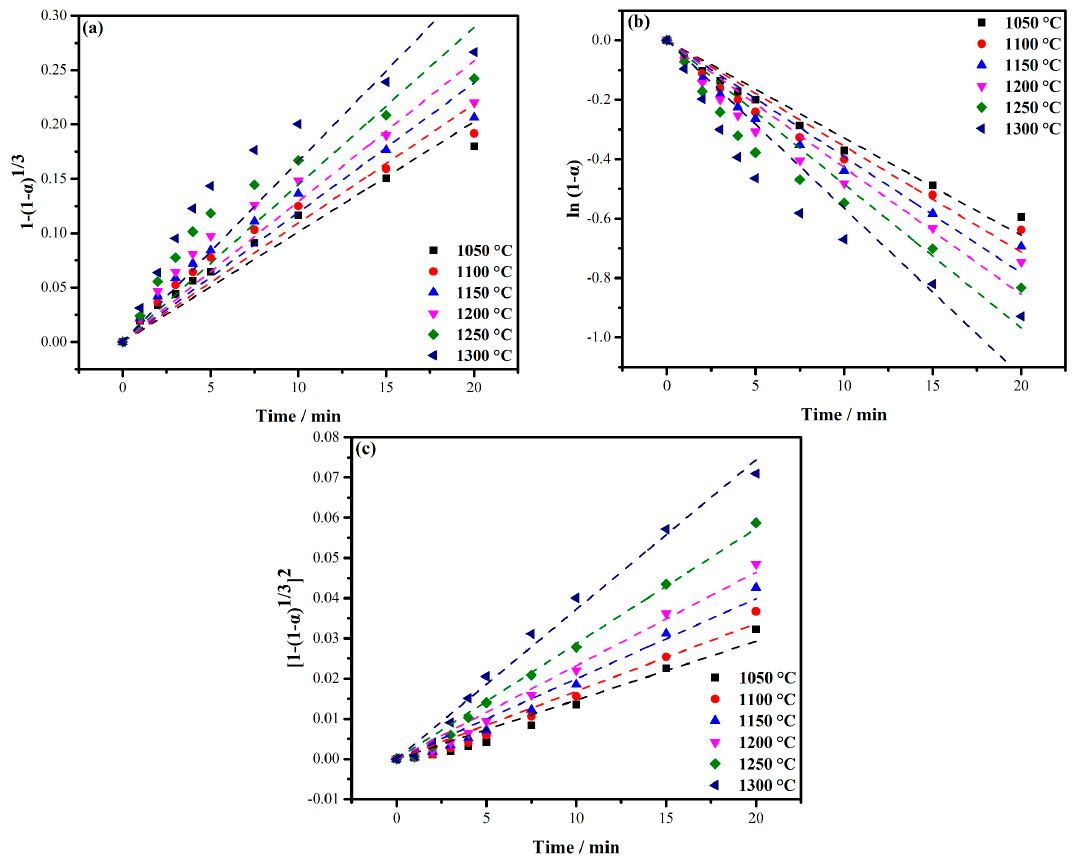
Figure 13. The calculated lines of different kinetic models—( a ) Equation (2), ( b ) Equation (3), and ( c ) Equation (4)—under various temperatures.